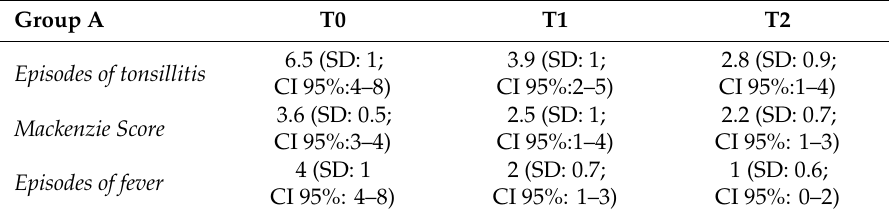
Figure 2. Variation within each group by comparing T0, T1 and T2 for episodes of tonsillitis, Mackenzie Score and episodes of fever. Table 1. Average of clinical data in Group A observed at the three di ff erent follow-up